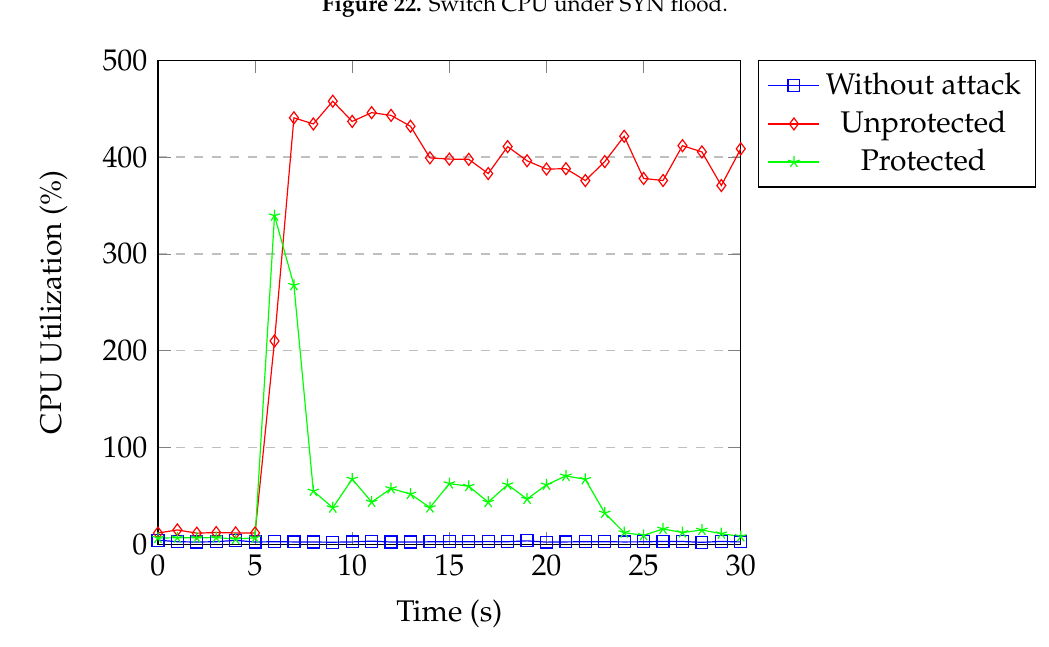
Figure 22. Switch CPU under SYN flood.